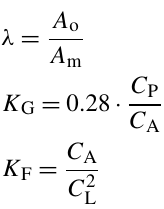
The plots of λ versus both parameters are presented in Fig. 5. Two equations, λ(K G ) and λ(K F ) (see Fig. 5), were calibrated using data from 14 randomly selected sections from the 21 assessed by the DEM. The remaining data were used to validate the equations. The FLM- λ model consists of processing the FLM as originally proposed and, afterwards, multiplying the output area by the λ correction parameter. As λ ≥ 1 . 0, the multiplication simulates the effect of wall